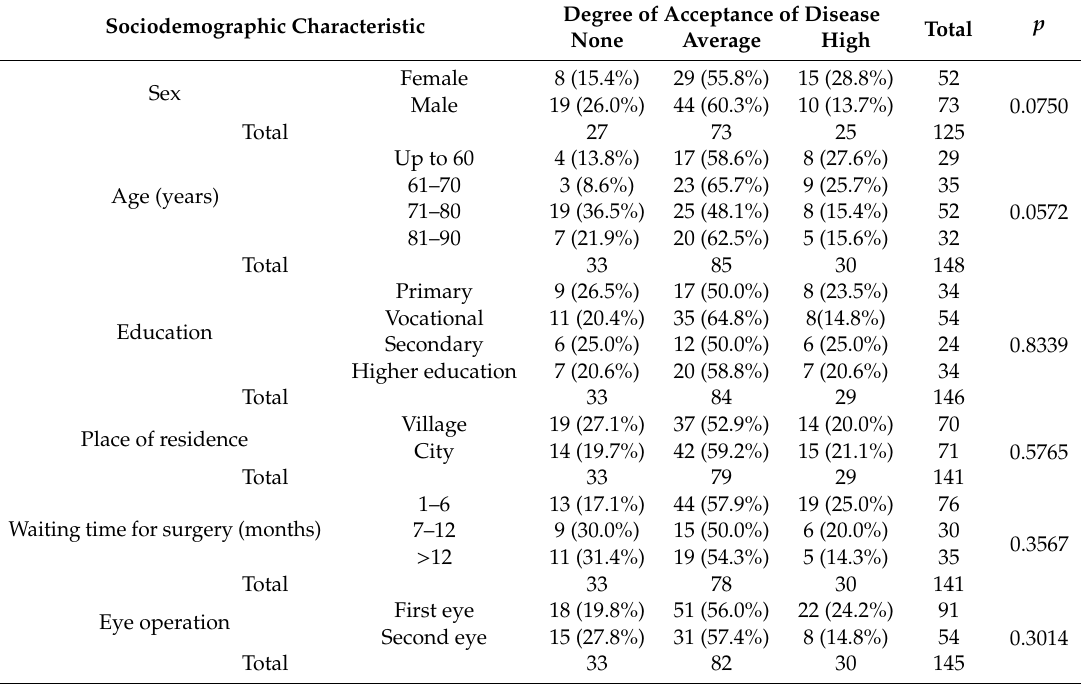
Table 9. E ff ect of selected sociodemographic characteristics on the level of acceptance of the disease with reference to the degree of